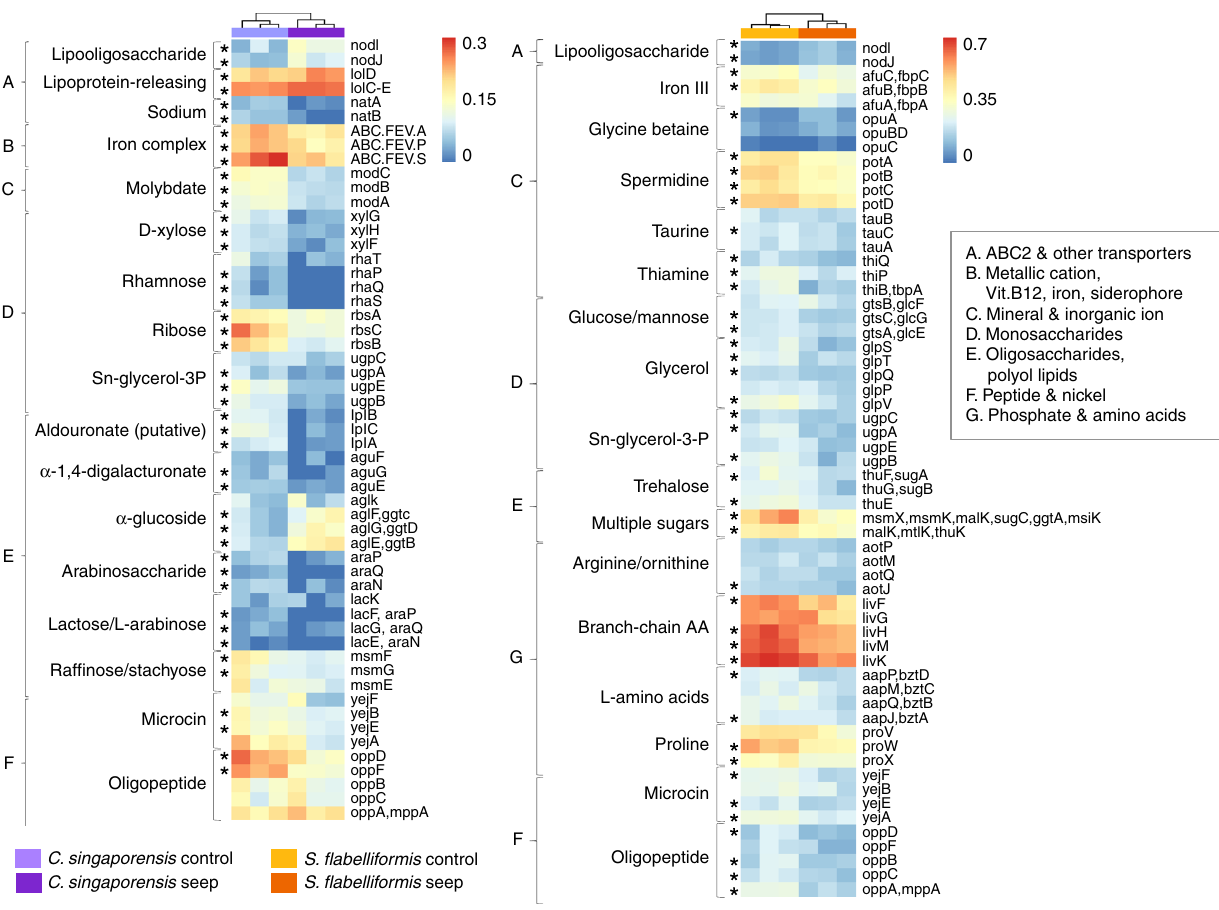
Fig. 2 Microbial genes affecting uptake of exogenous compounds at the CO 2 seep in C. singaporensis and S. fl abelliformis . Heatmap showing genes encoding ATP-Binding Cassette (ABC) transporters signi fi cantly affected by site. Data shown as square-root transformed mean ( n = 3) relative abundance calculated on rare fi ed data for each sponge species. Asterisk denotes p < 0.05 according to